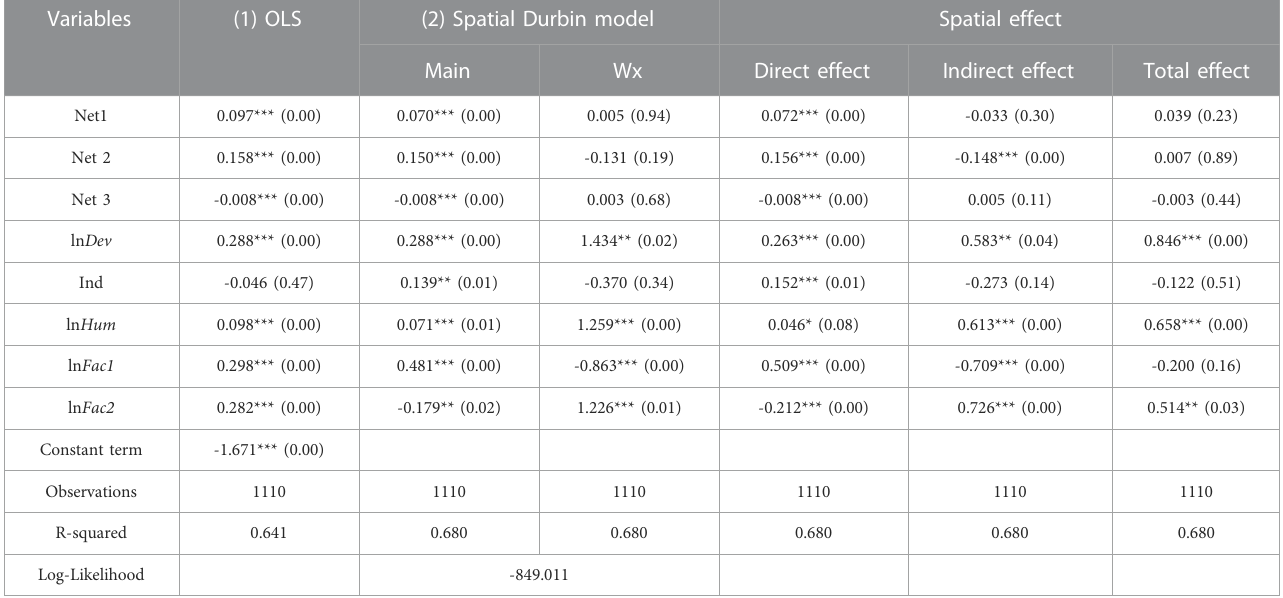
TABLE 6 Estimation results of the spatial Durbin model and spatial